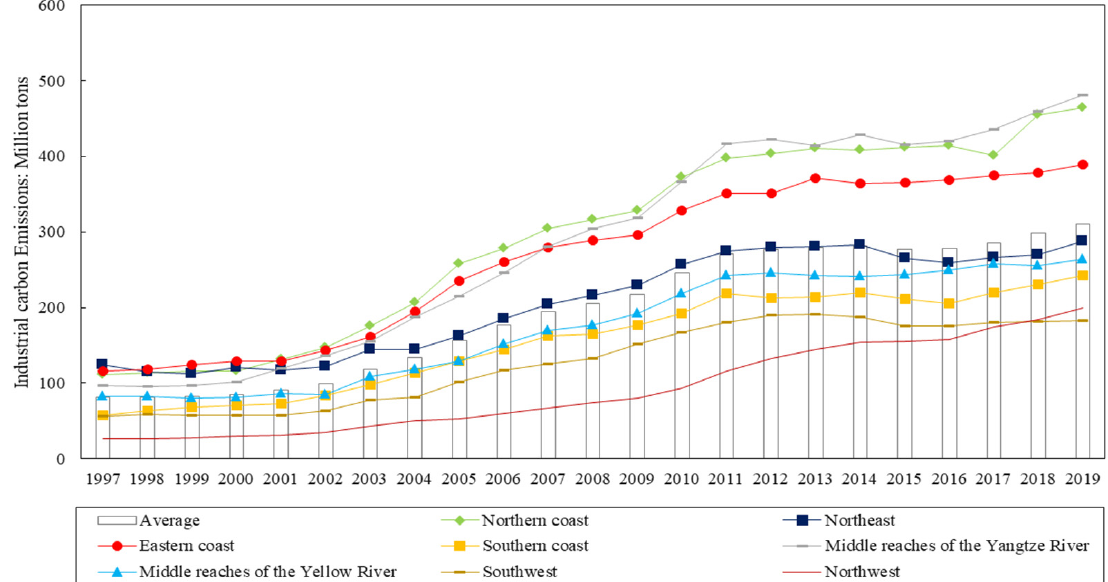
Figure 3. Changes in average industrial carbon emissions in China’s eight major economic zones.